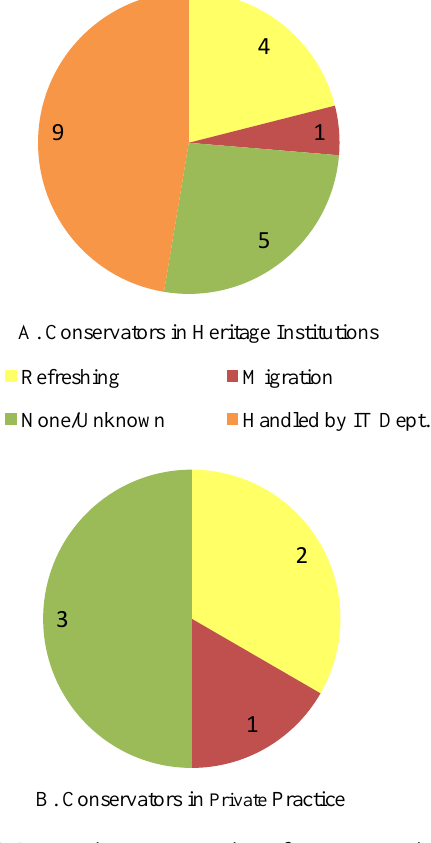
Figure 2. Data maintenance practices of conservators in